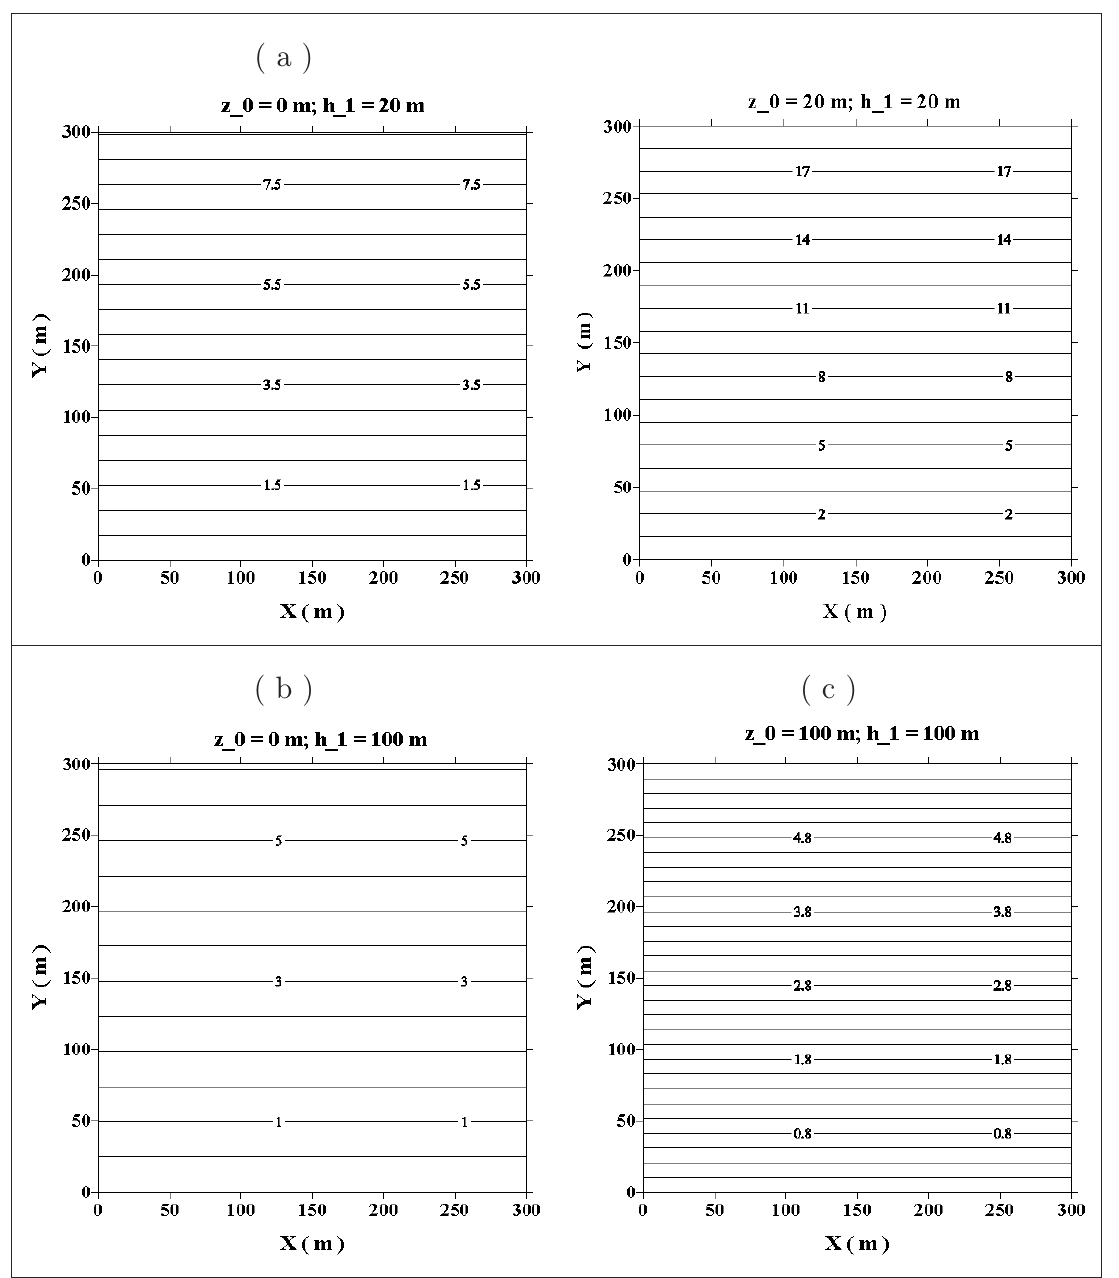
Fig. 8 – Contour maps of the difference of the vertical component of the magnetic field in nanotesla between one substratum with σ 2 = 0 . 3 S/m and another with σ 2 = 0 . 03 S/m. h 1 represents the thickness of the sea